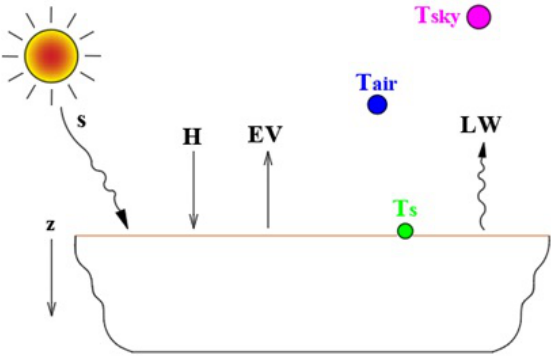
Fig. 3. Ground surface subjected to various heat